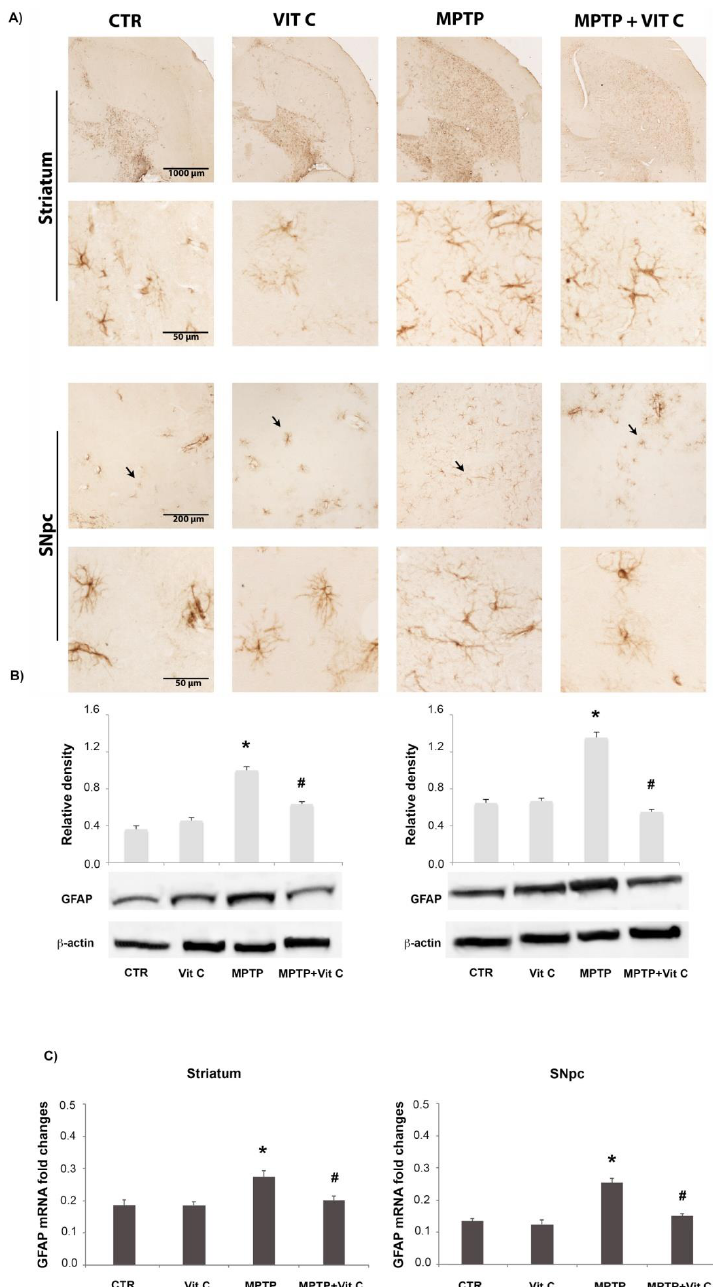
Figure 2. GFAP analysis. ( A ) GFAP immunoreactive astrocytes in the striatum (upper) and SNpc (lower) of controls (CTR), mice treated with Vitamin C (VIT C), MPTP, MPTP, and Vitamin C (MPTP+ VIT C). Scale bar: (striatum) upper 1000 µ m (obj. 4 × ), lower 50 µ m (obj. 40 × ); (SNpc) upper 200 µ m (obj. 4 × ), lower 50 µ m (obj. 40 × ). In low magnification images, arrows point to GFAP immunoreactive cells shown in high magnification ones. ( B ) Western blotting detection and densitometric analysis of GFAP expression levels in controls (CTR), mice treated with Vitamin